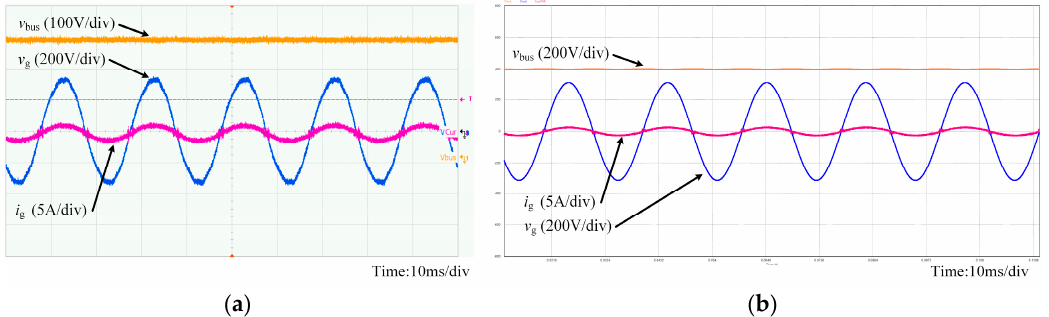
Figure 16. Experimental waveforms of the inverter at low power: ( a ) experiment waveform; and ( b ) simulation waveform.